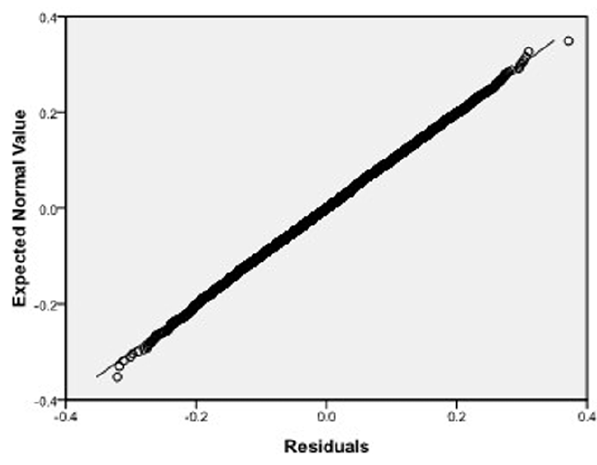
Figure 27. Histogram and asymptotic distribution for ^ bb 2 of OLS when the variance function of the error term is